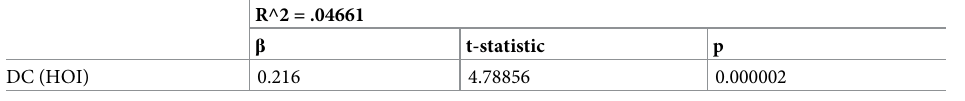
Table 5. Regression of the dependent variable–the economic effectiveness of the organization in relation to dynamic